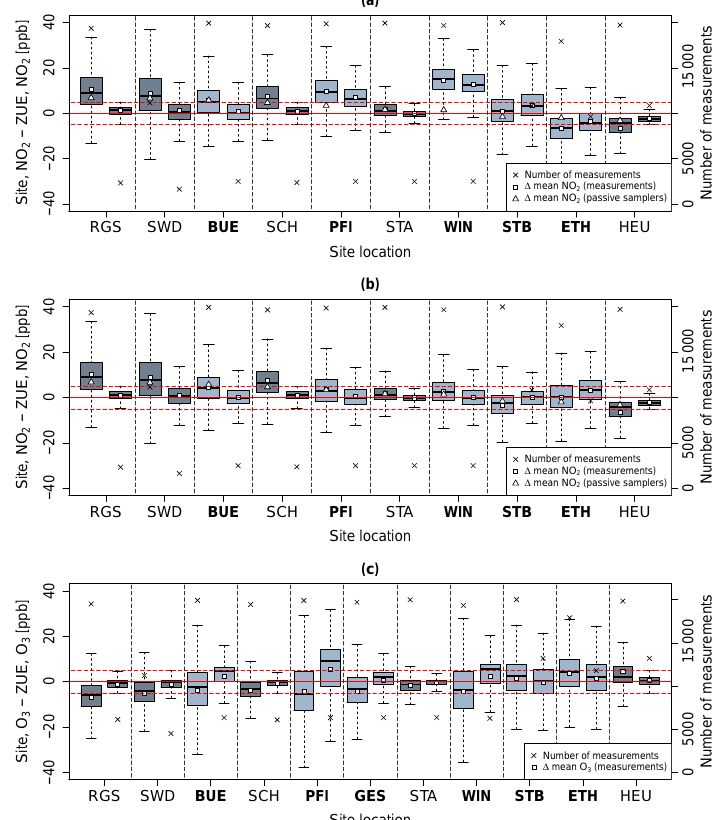
Figure 8. Analysis of the differences between NO 2 and O 3 measurements from the SUs (names of the sensor network locations in bold)/AQM sites and measurements from the AQM site ZUE. The comparison is twofold: for each site, the boxes on the left include all measurements while the boxes on the right only include the measurements when concentration ranges are below 5ppb for the AQM site groups background and city. Measurements of DS 2 are used in (a) . Measurements of DS 3 are used in (b, c) . Note that the sensor network locations STB and ETH refer to the group background (HEU, ZUE) and the locations BUE, PFI, GES and WIN refer to the group city (RGS, SCH, STA, ZUE).